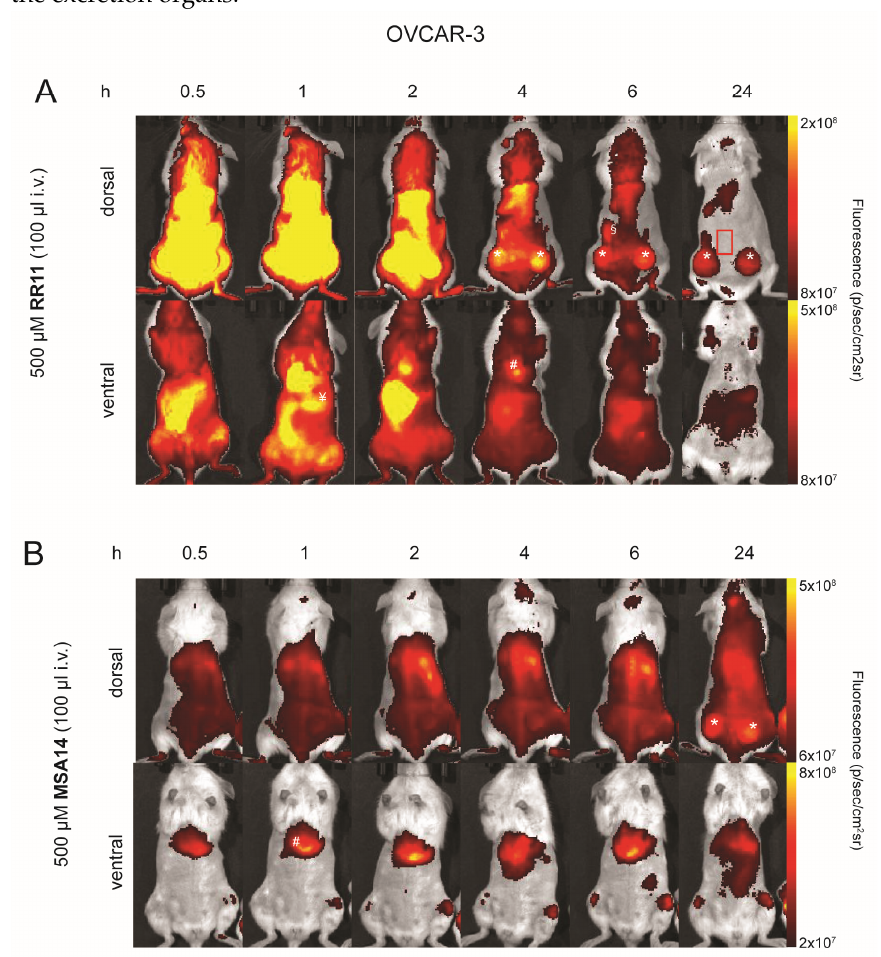
Figure 3. Biodistribution of RR11 and 23 (MSA14) in OVCAR-3 s.c. models: RR11 ( A ) and 23 (MSA14) ( B ) biodistribution was assessed by longitudinal “in vivo” whole body NIR FLI at six different time points (0.5, 1, 2, 4, 6, and 24 h) after intravenous (i.v.) injection of the fluorescent compounds. The fluorescence signal in the tumors (*), liver (#), kidney (§), stomach (¥), and background in the flank muscle (red square), presented by one representative mouse, were calculated with the IVIS spectrum living imaging software and expressed as radiance